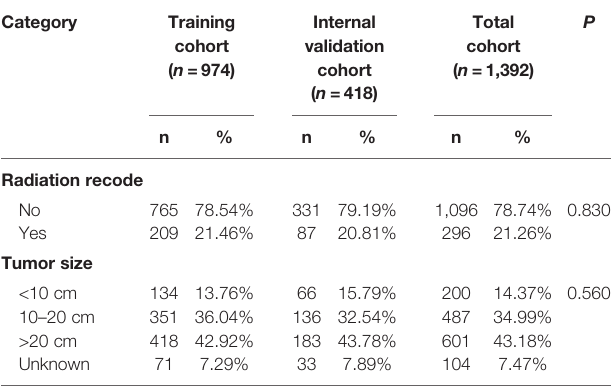
TABLE 1 | Demographics and clinicopathologic characteristics of SEER Patients with